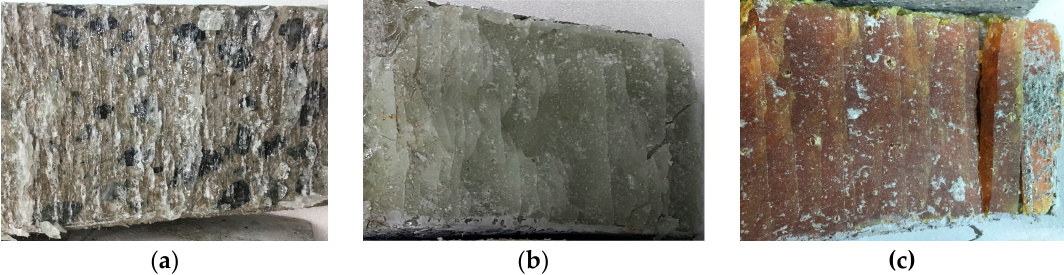
Figure 10. States on the remaining epoxy adhesive after the shear failure: ( a ) Adhesive 1; ( b ) Adhesive 2; ( c ) Adhesive 3.